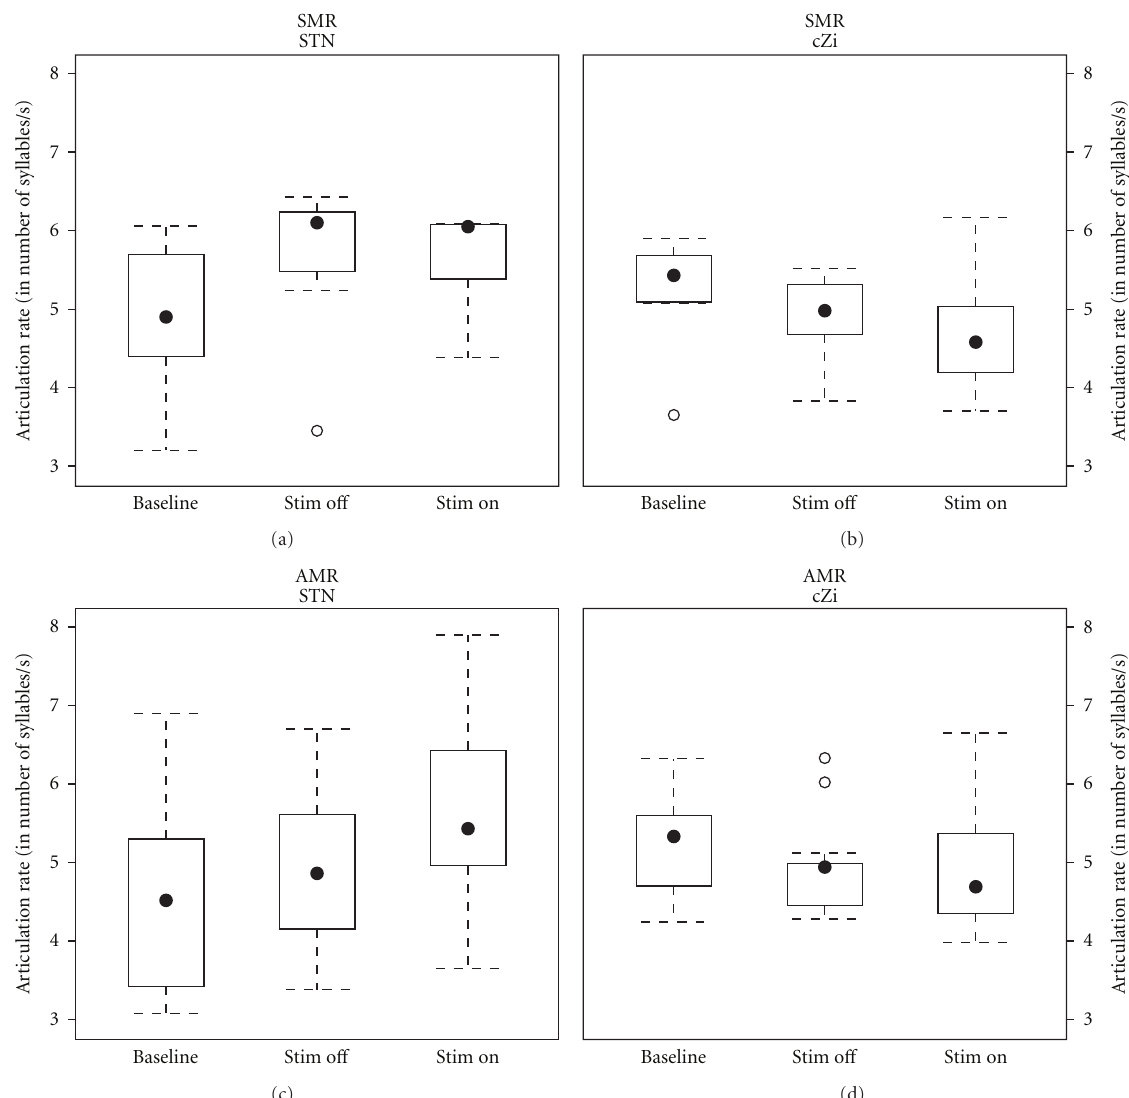
Figure 1: Box plot showing articulation rate under the three stimulation conditions for the two investigated patient groups and speech tasks.